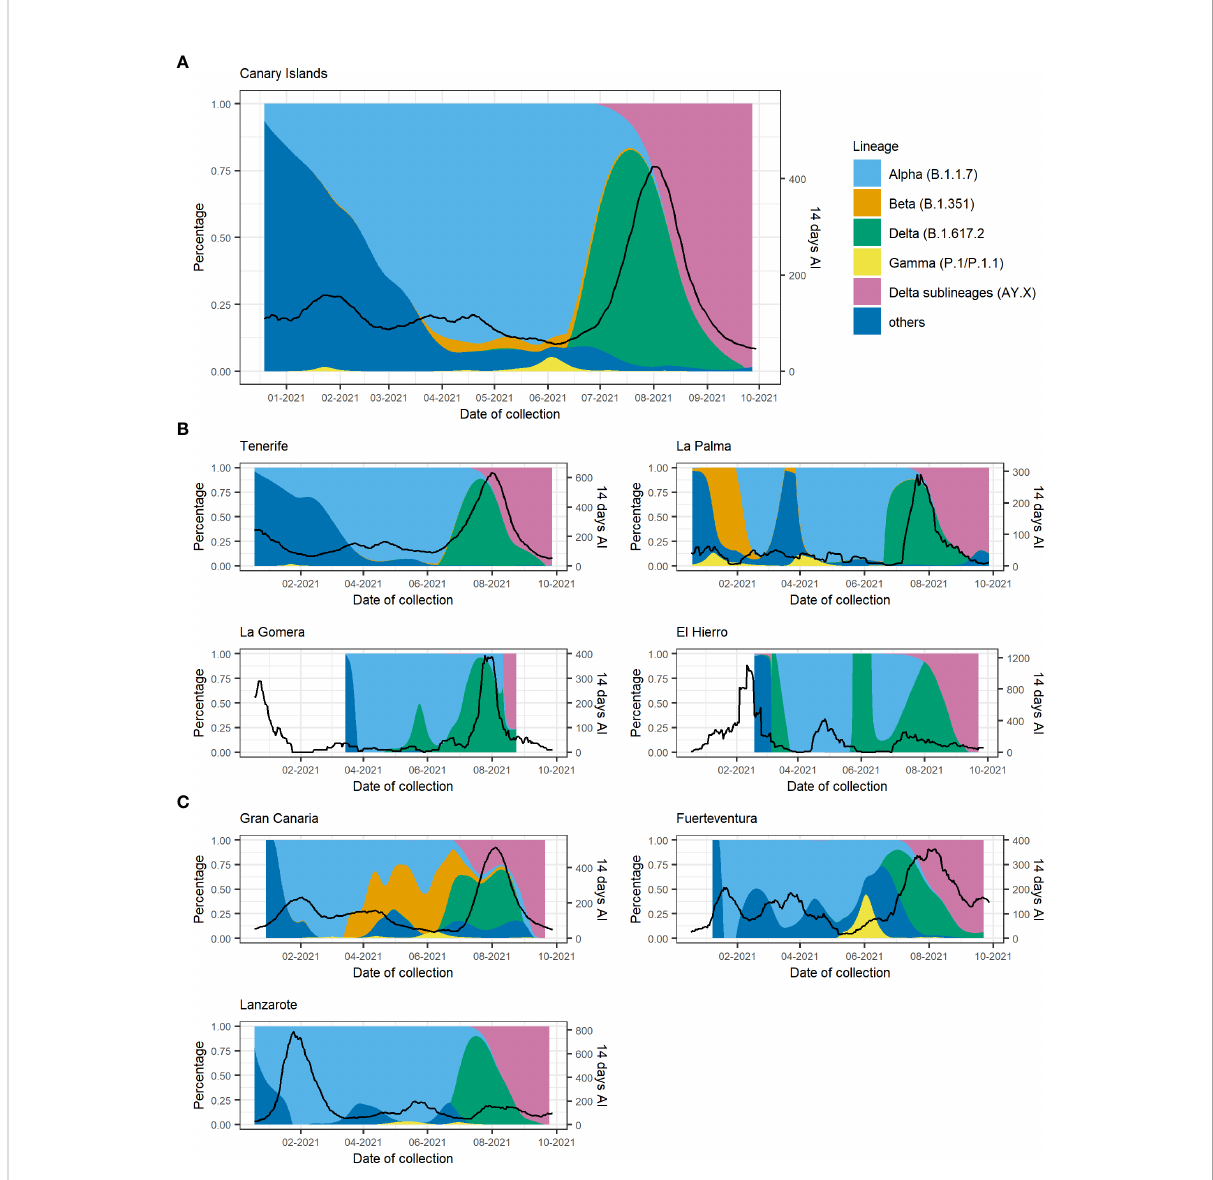
FIGURE 3 Proportion of variants of concern (VOCs) and the 14-day accumulated incidence throughout the study period for (A) the Canary Islands as a whole and disaggregated by island for (B) the Tenerife province and (C) the Gran Canaria province. Black lines depict the 14-day accumulated incidence. AY.X denotes the sublineages of Delta